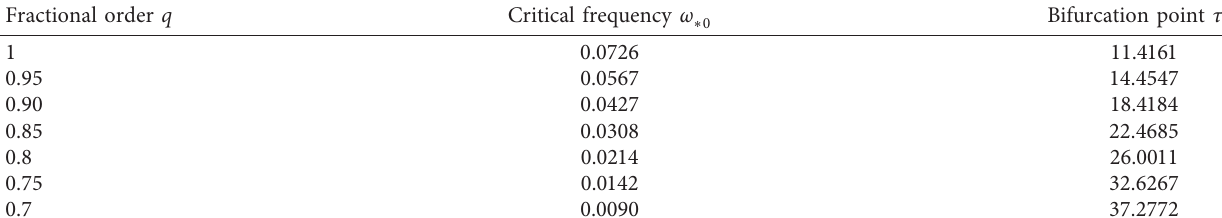
, and τ of model ∗ 0 ∗ 0